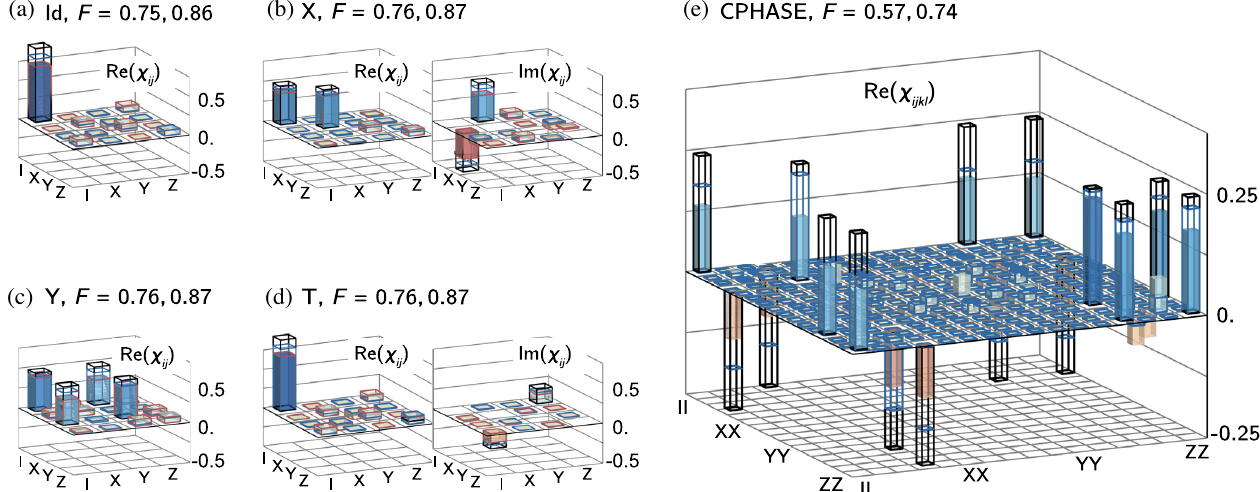
(blue wire frames) and without χ (filled bars) accounting for state preparation errors for int meas (black wire frames) process maps. F ¼ F ffiffiffiffiffiffiffiffiffiffiffiffiffiffiffiffiffiffiffiffiffiffiffiffiffiffiffiffiffiffiffiffiffiffiffiffiffi ideal p ffiffiffiffiffiffiffi p p χ χ Þ 2 . Imaginary parts (not shown) are all below 0.04 in χ ¼ Tr ð int int ideal int